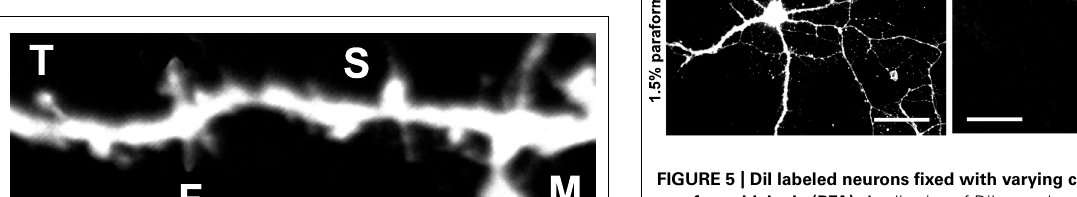
FIGURE 5 | DiI labeled neurons fixed with varying concentrations of paraformaldehyde (PFA). Application of DiI crystals on fixed cells produces a very high degree of detail. (A) Cell fixed with 4.0% PFA. (B) The use of 4.0% PFA fixative significantly compromises DiI diffusion through the dendrites. Multiple varicosities are highlighted along the dendrite and spines are poorly resolved. (C) Cell fixed with 2.0 % PFA. (D) The use of 2.0% PFA generates high quality DiI labeling of spines.Various subtypes of spines are evident along the dendritic segment. ( E) Cell fixed with 1.5% PFA. (F) The use of 1.5% PFA yields comparable results to the use of 2.0% fixative. Fine, thin filopodial projections are resolved. Scale bar (A,C,E) = 50 μ m; Scale bar (B,D,F) = 5 μ